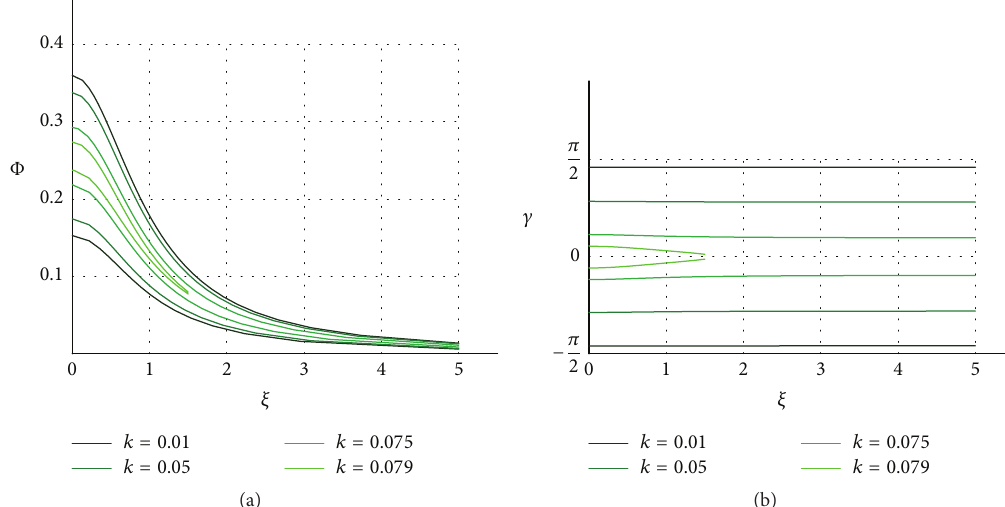
Figure 7: (a) Amplitude-frequency and (b) phase-frequency characteristics of the system at various friction coefficients 𝑘 , for ] = 0.2 and 𝑓 = 0.1 .